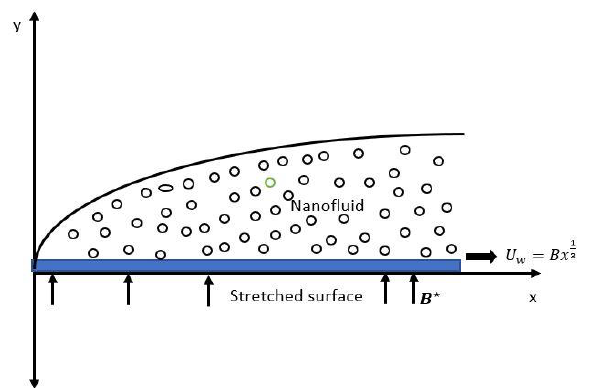
Figure 1. Flow geometry of the problem.